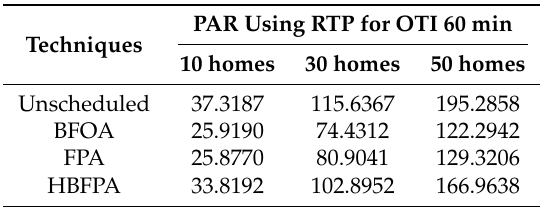
Table 23. Peak to average ratio for 24 h (for multiple